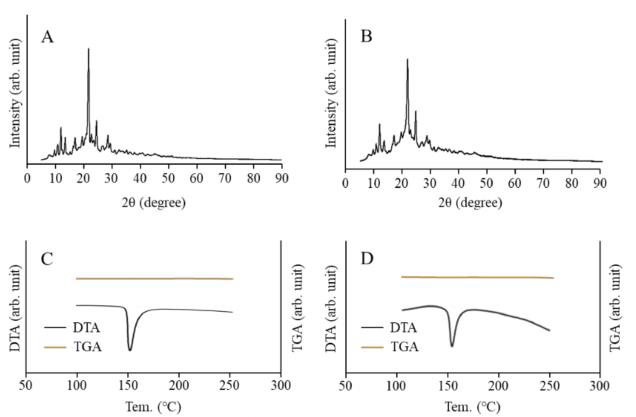
Figure 2. Analysis of crystalline structure and characteristics in NIL particles treated with or without a bead mill. ( A , B ): The powder X-ray diffraction patterns of NIL-MP ( A ) and NIL-NP ( B ) dispersions. ( C , D ): The TG-DTA curve of NIL-MP ( C ) and NIL-NP ( D ) dispersions. Many diffraction peaks were detected in the NIL-NPs. The peak patterns of the XRD in the NIL-NP dispersions were similar to those of the NIL-MPs, and the melting point of the NIL-NPs was not changed by the bead mill treatment.